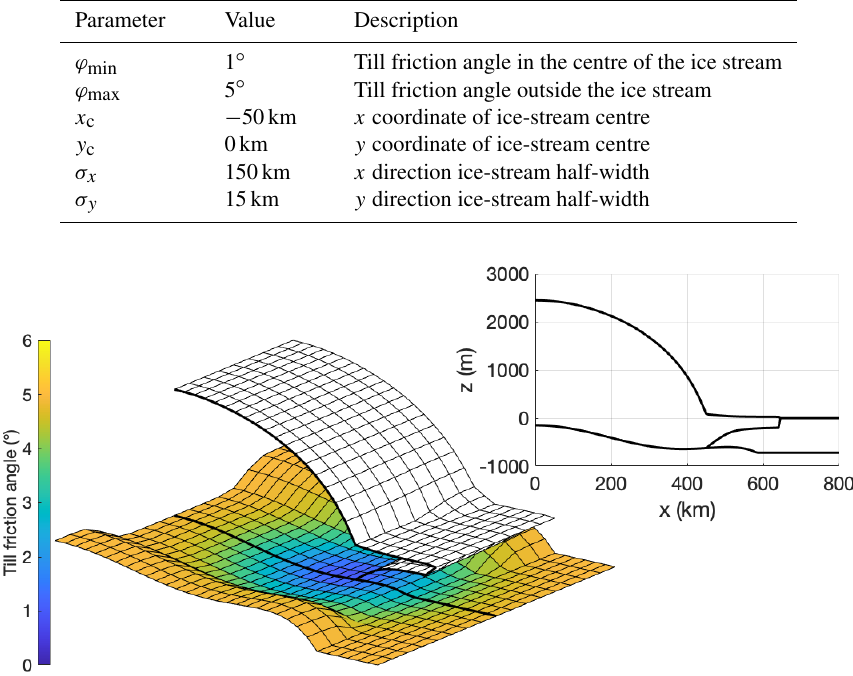
Figure 3. Bed roughness and steady-state ice-sheet geometry in the MISMIP+-based experiment II. Black lines on the ice surface are only for illustration. They do not correspond to the model grid. The top-right panel shows a transect at y = 0, along the central